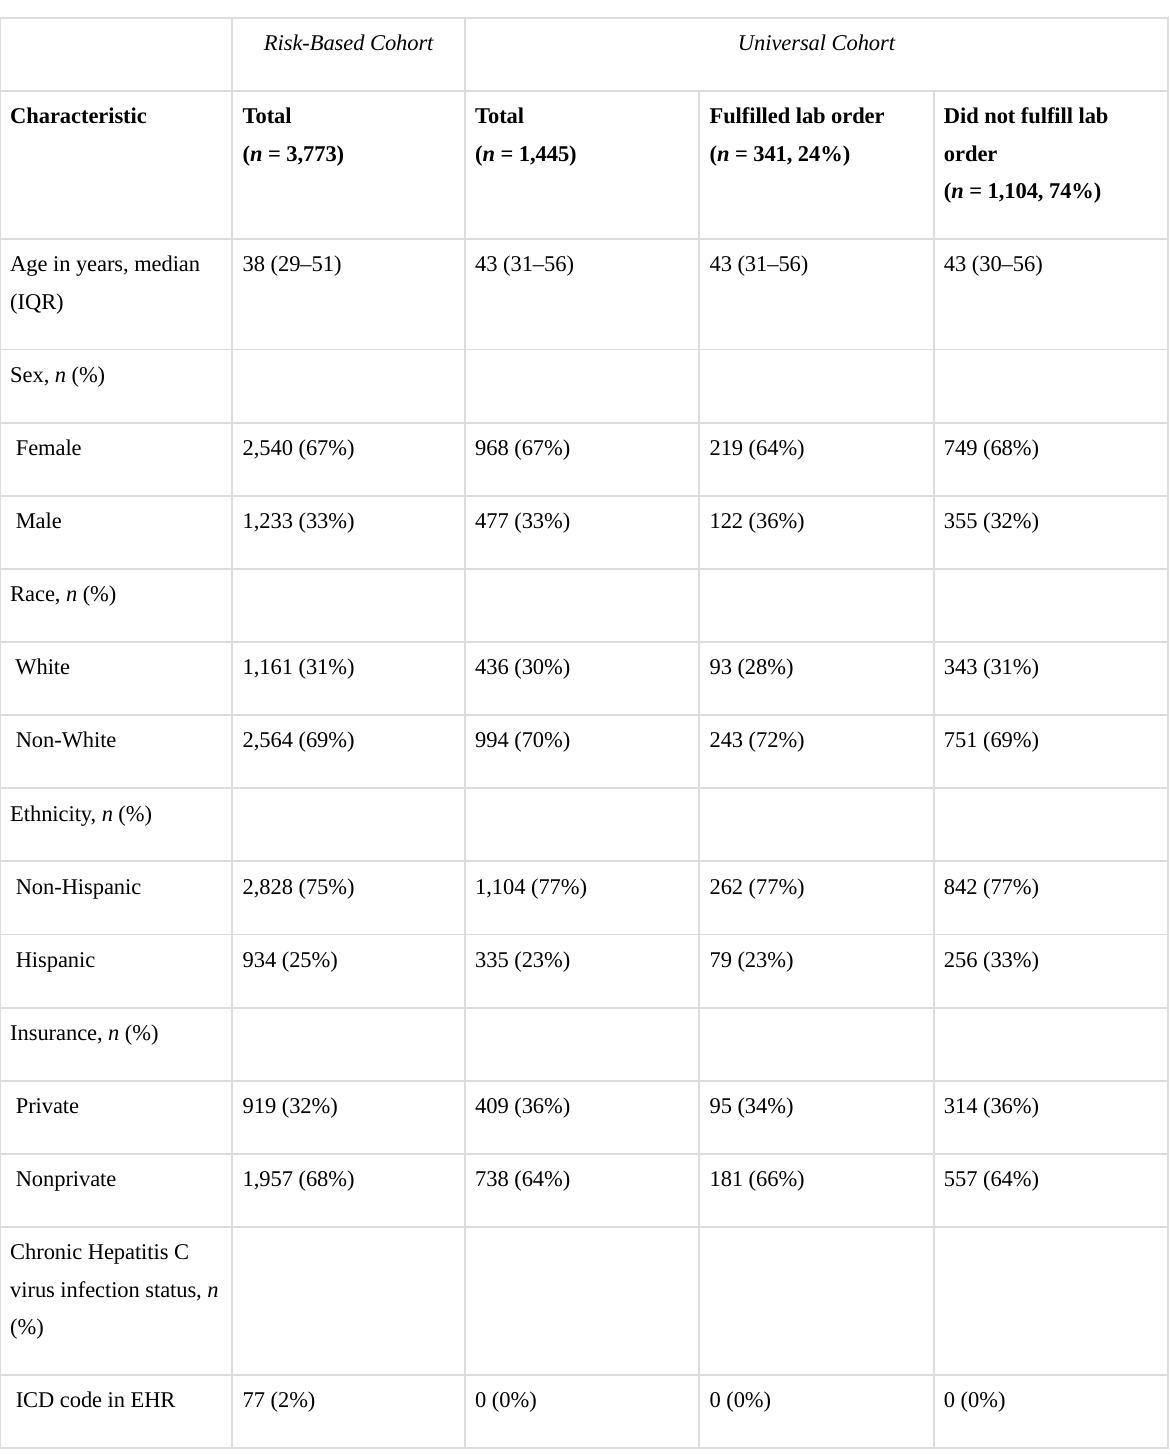
Table 1. Characteristics of the two cohorts of patients seen at an urban federally qualified health center for classifying true chronic hepatitis C virus infection status based on an electronic health record